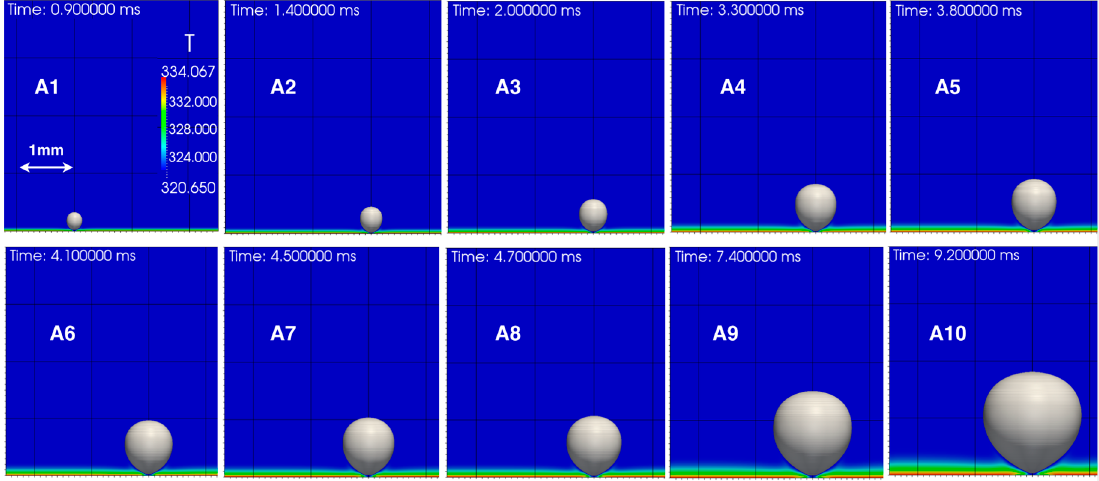
Figure 12. Spatial evolution of generated bubble at the time of detachment for each case of Series A.